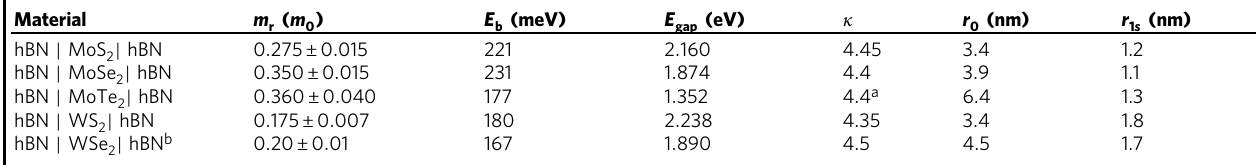
Table 1 Fundamental optoelectronic material parameters of monolayer TMD semiconductors Material m r ( m 0